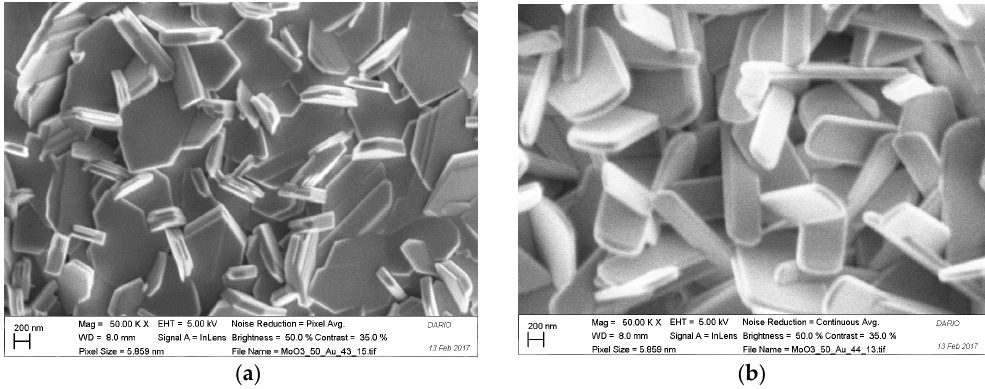
Figure 1. The SEM image of the MoO 3 nano structures at evaporation temperature 700 °C, pressure 10 mbar and 10SCCM Ar flow: ( a ) At low temperate zone (450 °C–500 °C); ( b ) At high temperature zone (500 °C–550 °C).